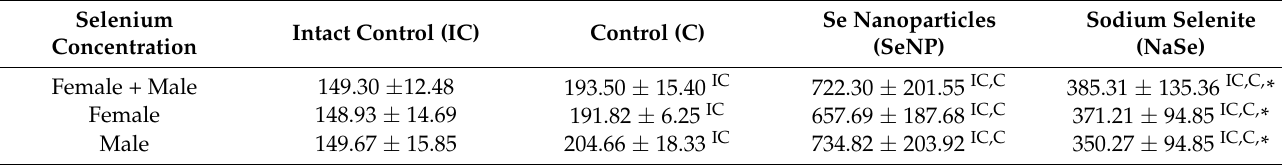
Table 5. The concentration of Se in the placenta of female and male rat embryos. The groups were as follows: intact controls (IC); controls (C); Se nanoparticles-treated group (SeNPs); sodium selenite- treated group (NaSe). The data are expressed as the mean ± S.D. The independent t -test by groups was used for comparisons between a group with p < 0.05 as the level of significance. Significant differences between treated groups: IC concerns the intact control; C concerns the control